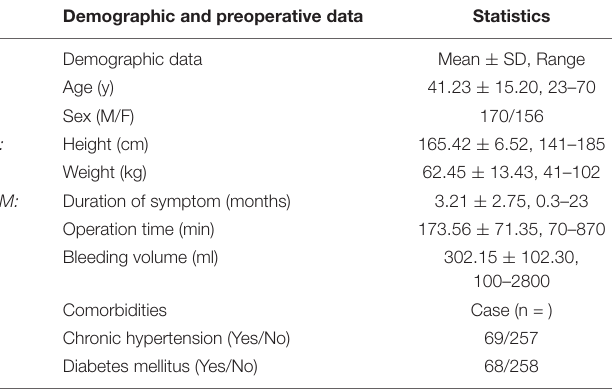
TABLE 1 | Summary of demographic and preoperative